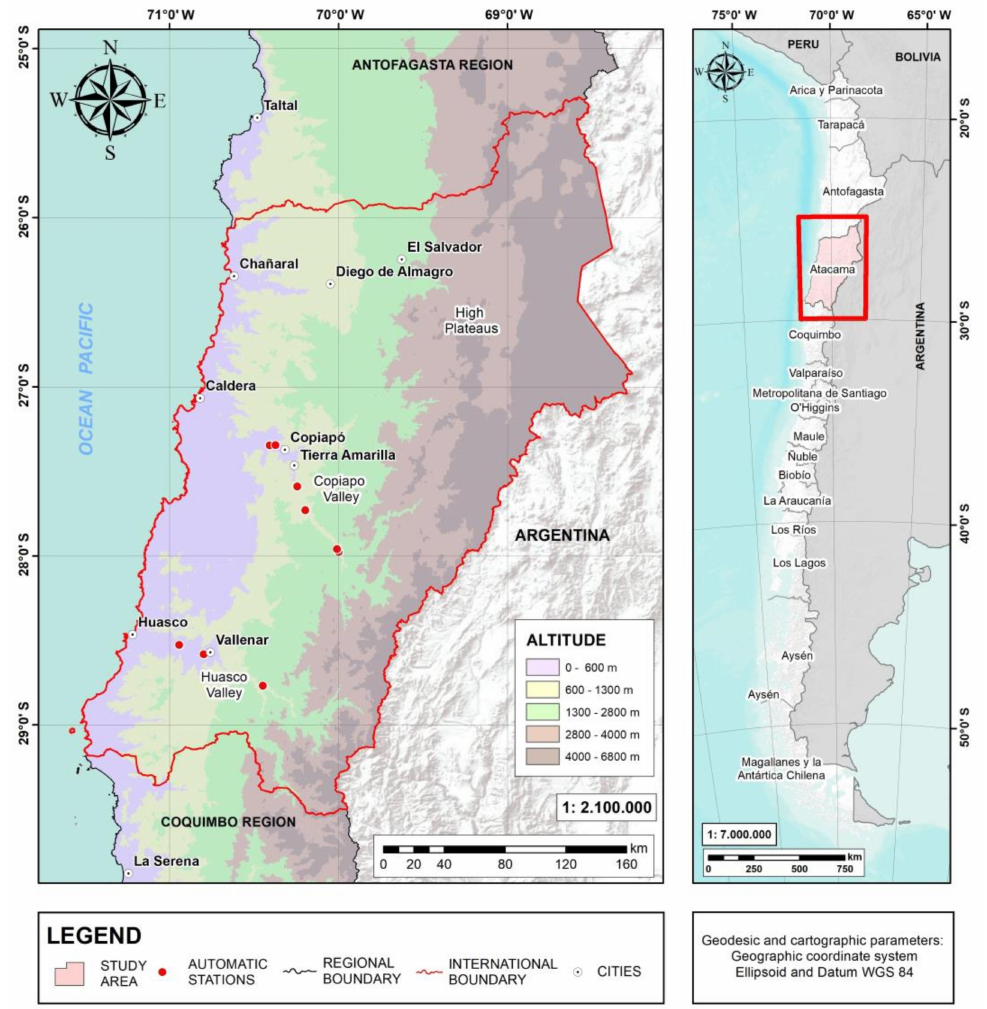
Figure 1. Study area: the Atacama region, Chile, with the automatic weather stations (AWSs) analyzed in this